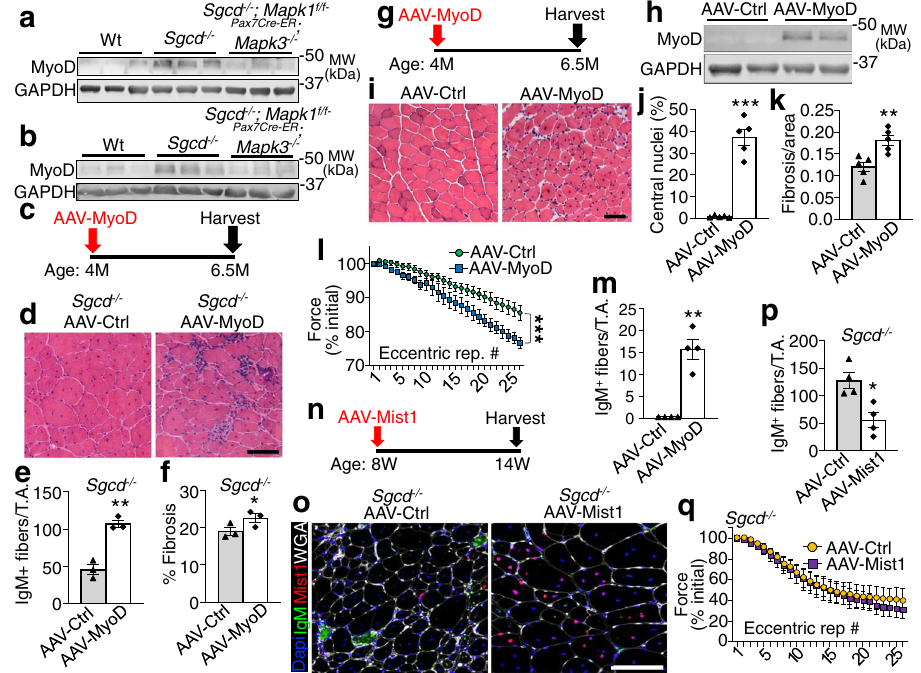
Fig. 4 Ectopic MyoD expression destabilizes the sarcolemma in vivo. Western blotting for MyoD protein expression using Quad lysate from 2- or 4-month-old mice of indicated genotypes treated with Tmx starting at 2 ( a ) or 8 ( b ) weeks of age. GAPDH is shown as loading control. Results from three different mice are shown. c Schematic for AAV-MyoD or AAV-control injection into Sgcd − / − mice at 4 months of age, harvested by 6.5 months. d H&E-stained TA muscle histological sections from Sgcd − / − mice injected with the indicated recombinant virus. Scale bar = 100 μ m. e IgM positive fi bers quanti fi ed in TA muscle histological sections with prior AAV-MyoD or AAV-control infection in Sgcd − / − mice. n = 3 mice per group, ** P <0.01 vs AAV-Ctrl, two-tailed Student ’ s t test. f Picrosirius red-stained histological section of the TA muscle for quantitation of fi brosis in Sgcd − / − mice with prior AAV-MyoD or AAV-control infection. n = 3 mice per group, * P <0.05 vs AAV-Ctrl, two-tailed Student ’ s t test. g Schematic of recombinant AAV treatment in Wt mice. h Western blot for MyoD from TA muscle of Wt mice 2.5 months after AAV injection. GAPDH was run as a loading control. Results from two different mice are shown. i H&E-stained TA muscle histological sections from Wt mice injected with the indicated recombinant virus. Scale bar = 100 μ m. j Quantitation of myo fi ber number with central nucleation in H&E-stained histological sections from the TA muscle with prior AAV-MyoD or AAV-control infection in Wt mice. n = 5 mice per group, *** P <0.001 vs AAV-Ctrl, two-tailed Student ’ s t test. k Quantitation of fi brosis in picrosirius red-stained histological sections from the TA muscle in Wt mice with prior AAV-MyoD or AAV-control infection. n = 5 mice per group, ** P = <0.01 vs AAV-Ctrl, two-tailed Student ’ s t test. l Percent change in force transduction for TA muscles subjected to continuous repetitive eccentric contractions in Wt mice injected previously with AAV-MyoD or AAV-Ctrl. The x -axis shows number of progressive repetitive (rep) contractions. A two-way repeated measures ANOVA was used to determine signi fi cance, n = 12 mice for AAV-Ctrl, n = 11 mice for AAV-MyoD, *** P <0.001 for interaction. m IgM positive fi bers quanti fi ed in TA muscle histological sections with prior AAV-MyoD or AAV-control injection in Sgcd − / − mice at the indicated times. o Immunohistochemistry from the TA muscle of Sgcd − / − mice injected prior with AAV-Mist1 or AAV-Ctrl, stained for IgM (green), Mist1 (red), Dapi for nuclei (blue) or myo fi ber outlines with wheatgerm agglutinin (white). Scale bar = 100 μ m. p IgM positive fi bers quanti fi ed in TA muscle histological sections of Sgcd − / − mice with prior AAV-Mist1 or AAV-control injection. mice. n = 4 mice per group, * P <0.05 vs AAV-Ctrl, two-tailed Student ’ s t test. q Percent change in force transduction in the hindlimb subjected to continuous repetitive eccentric contractions in Sgcd − / − mice injected previously with AAV-Mist1 or AAV-Ctrl. The x -axis shows number of progressive repetitive (rep) contractions. n = 7 mice for AAV-Ctrl, n = 8 mice for AAV- Mist1. Data represent mean±SEM for all